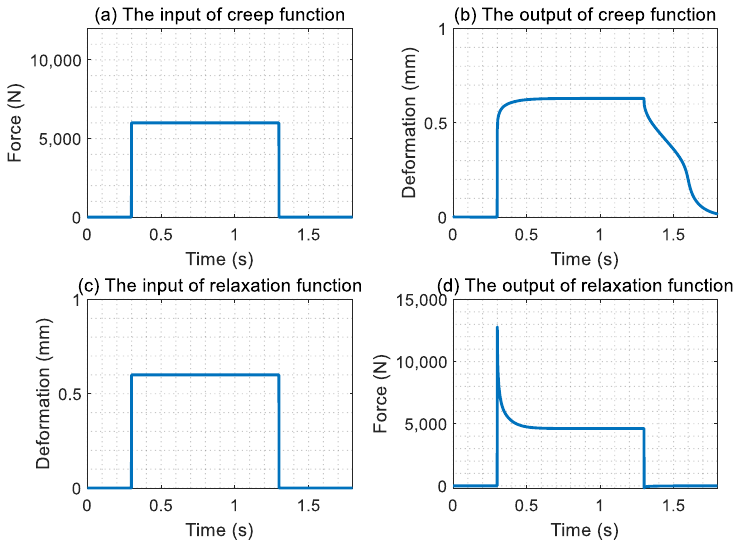
Figure 5. Creep and relaxation